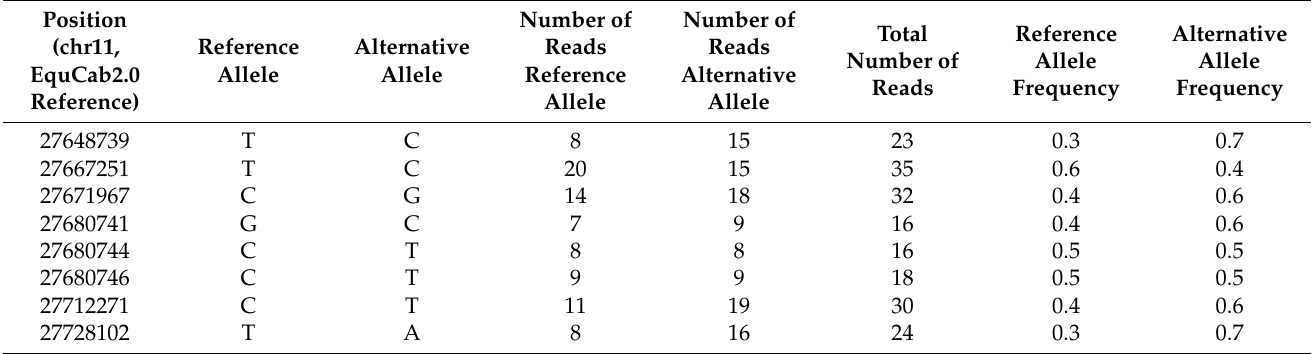
Table 2. SNV analysis of the genomic region corresponding to the CENP-A binding domain of chromosome